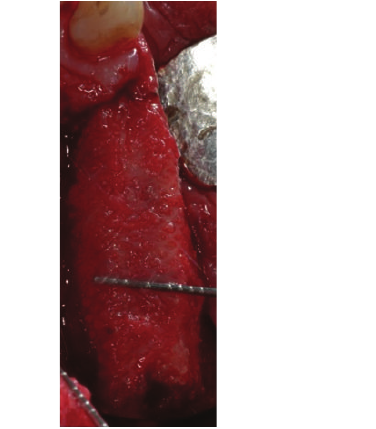
Figure 7: Occlusal view of the increased bone after the bone regen- eration procedure with the applied titanium mesh.